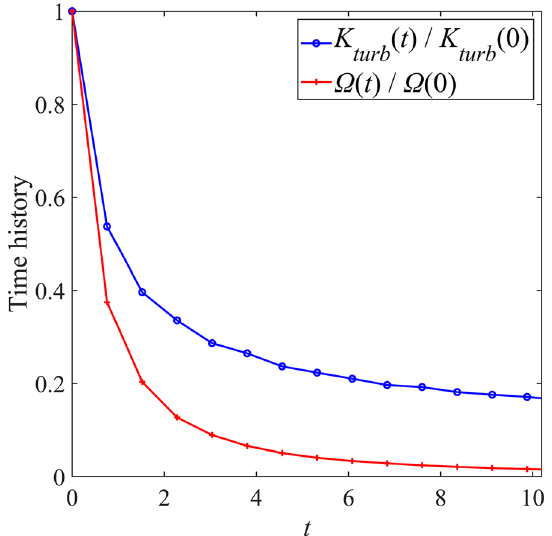
Fig. 5 Temporal evolution of the normalized turbulent kinetic energy and enstrophy for the case